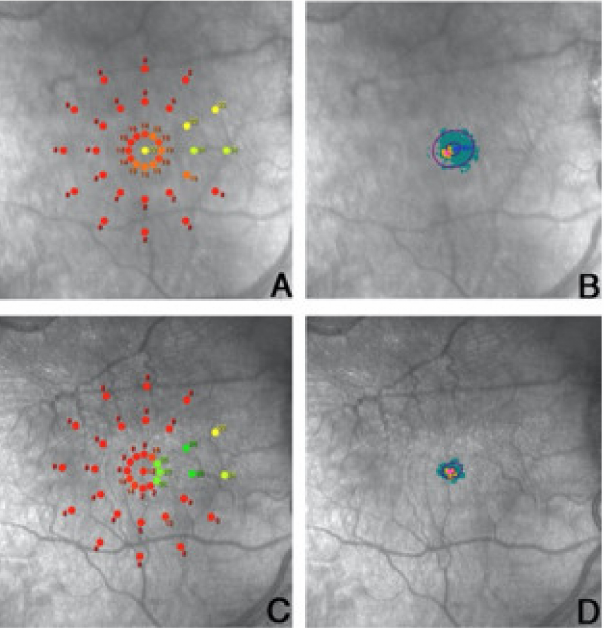
Figure 1. ( A ) Retinal sensitivity map of the RP patient and ( B ) fixation behavior of the patient, here represented by the bivariate contour ellipse area (BCEA), both prior to the training session. ( C ) Retinal sensitivity fixation map and ( D ) fixation behavior represented by the BCEA after the training session was completed. We can see here a substantial increase in the patient’s fixation behavior, which correlates with best corrected visual acuity (BCVA) improvement and with patient satisfaction after the training session. Images scale bar 300